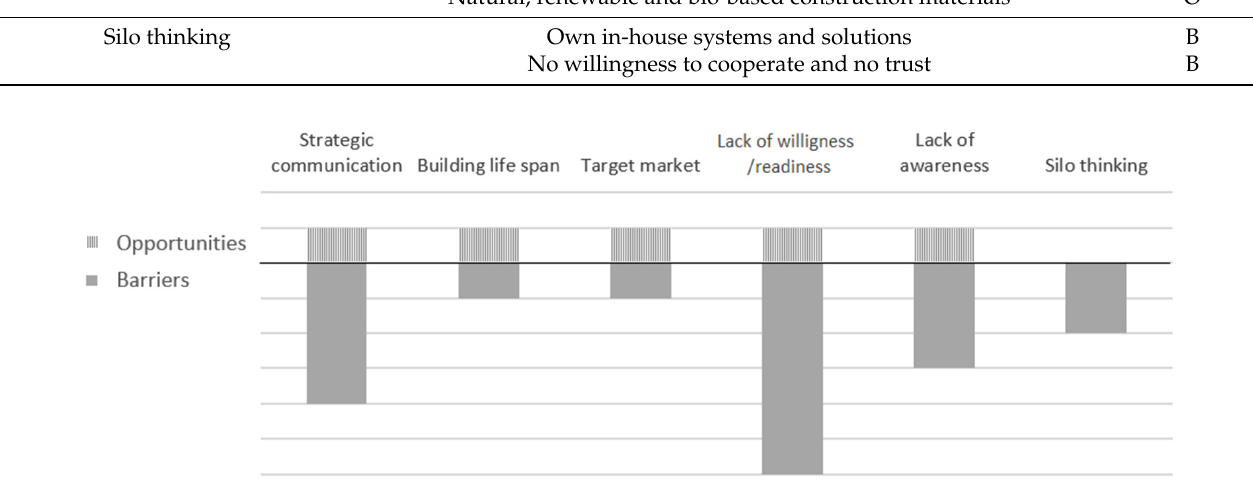
Figure 4. Relation of opportunities and barriers corresponding to the sub-codes allocated in each code of the category Acquisition